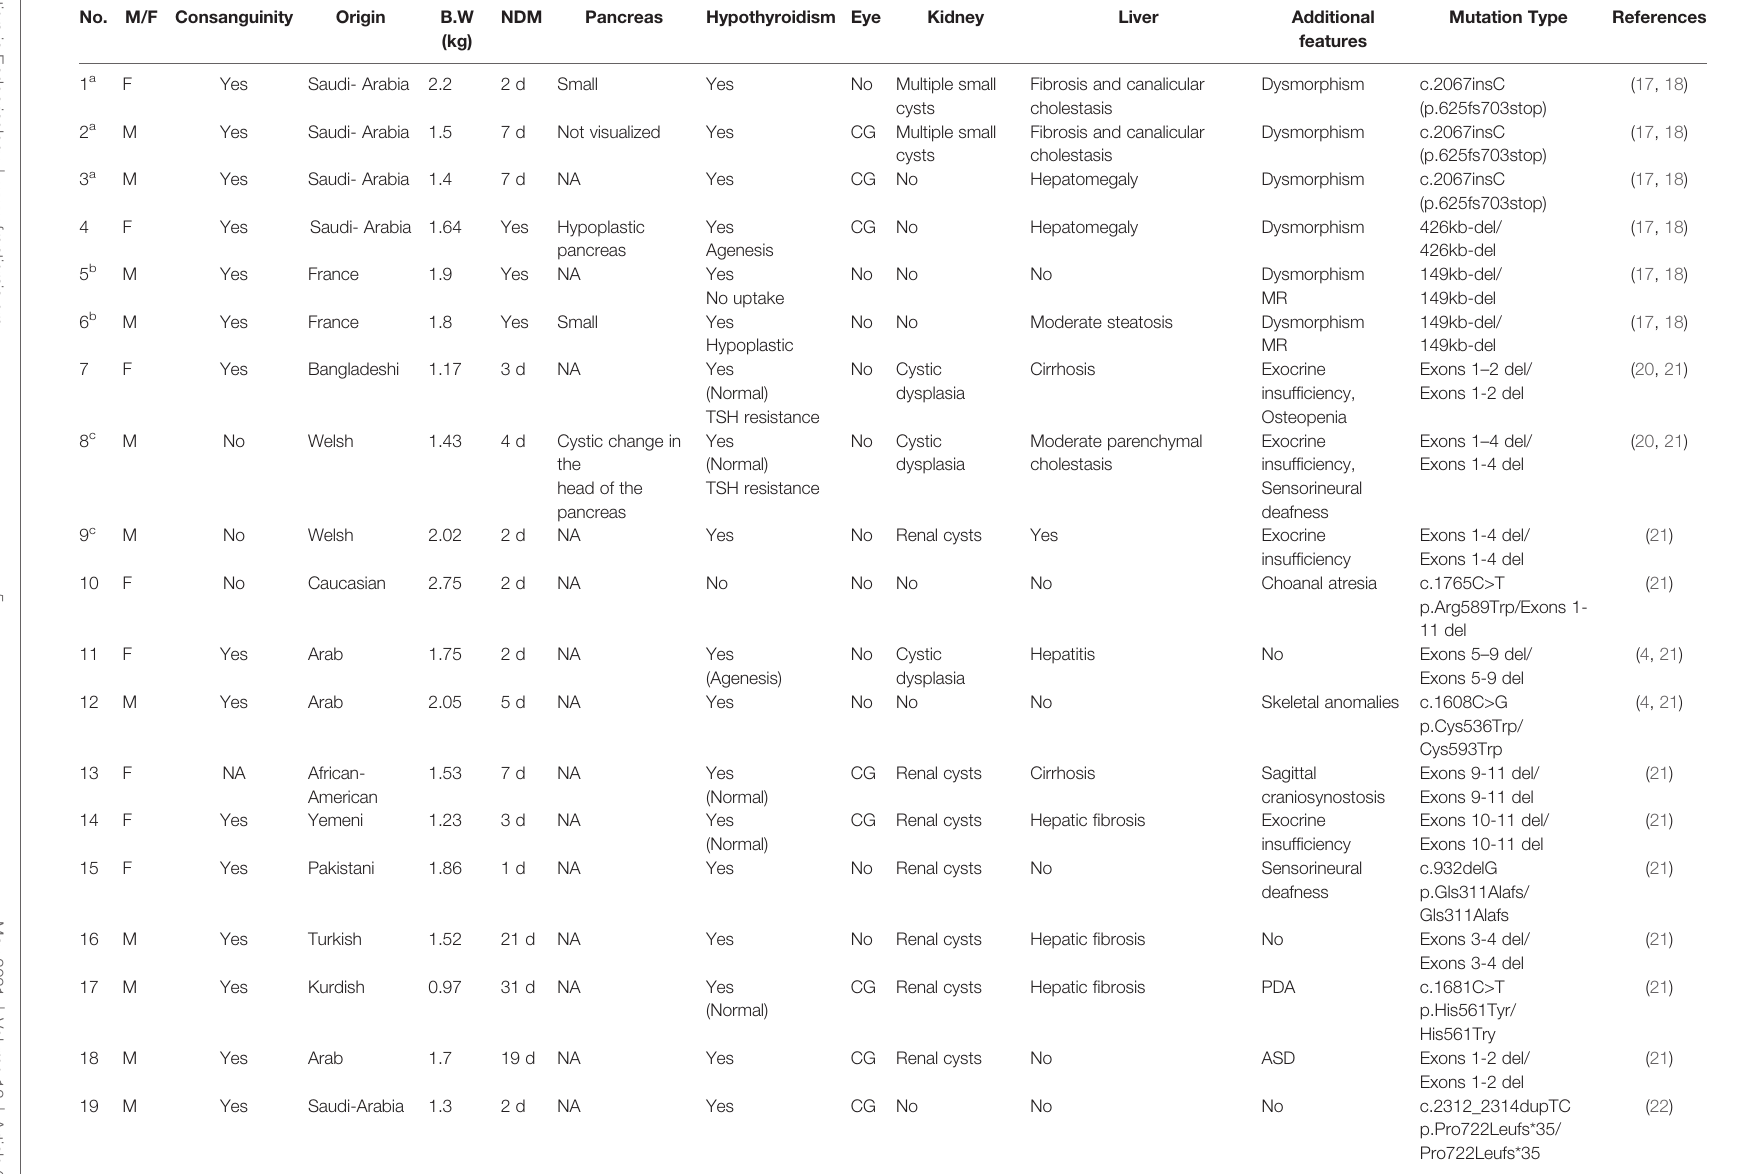
TABLE 2 | Clinical and molecular fi ndings of previous reported cases with GLIS3